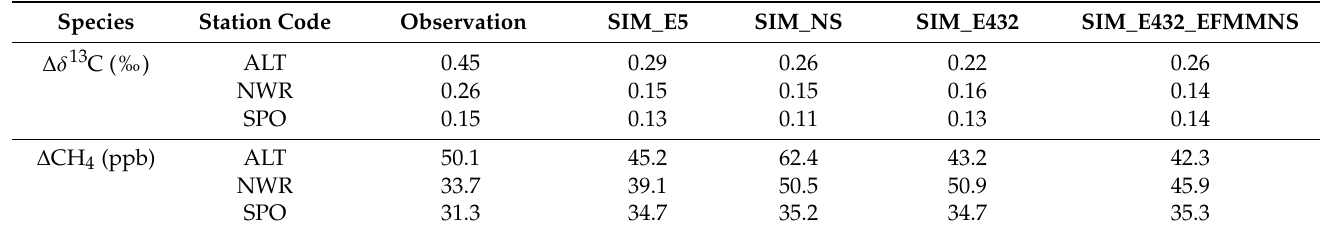
Table 5. Observed and modeled amplitudes of Δ 𝛿 13 C and Δ CH 4 at Alert (ALT), Niwot Ridge (NWR), and South Pole (SPO)